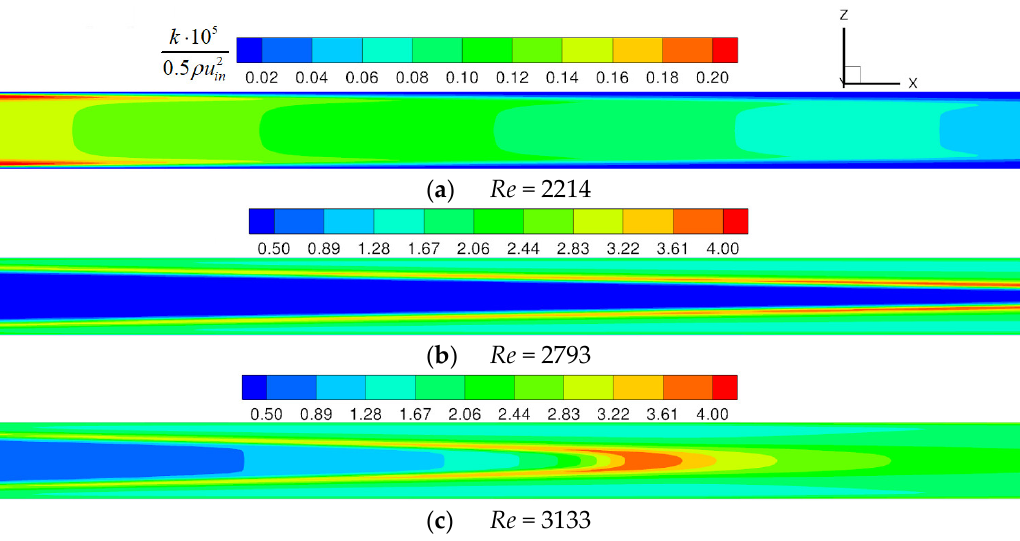
Figure 12. Dimensionless turbulent kinetic energy contours on the middle cross section.